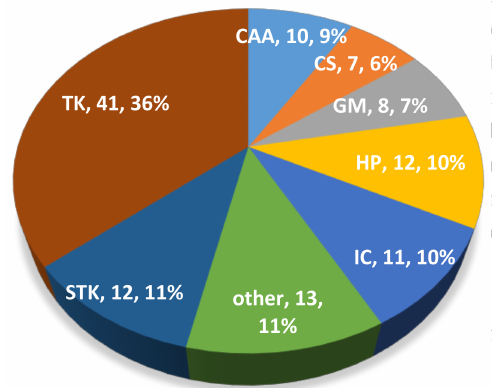
Figure 1. Targeted drugs approved for cancer were classified according to target type. TK: Tyrosine Kinase; STK: Serine Threonine Kinase; CAA: Cancer Associated Antigen; GM: Genome Maintenance; HP: Hormone Pathway; CS: Cytokine Signaling; IC: Immunological Checkpoint.